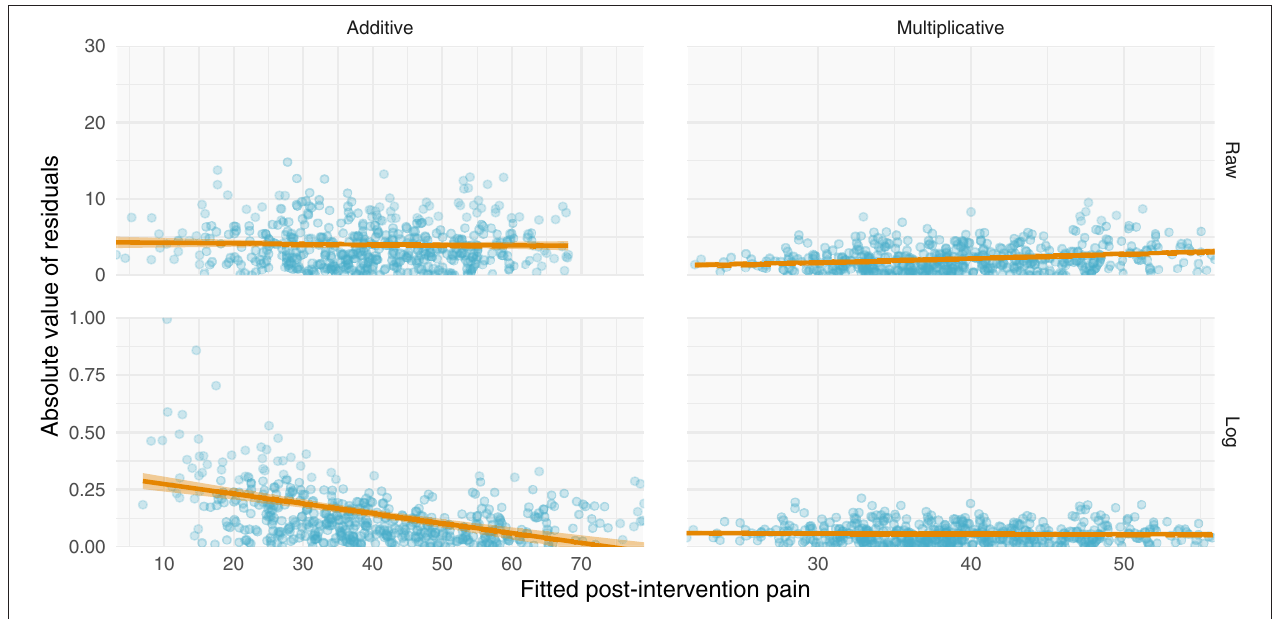
FIGURE 4 | Simulations of additive and multiplicative changes reveal differential residual behavior for raw and log-transformed ANCOVA models. (Left) data generated with have an additive structure have homoscedastic residuals when fit with a standard ANCOVA (top) but heteroscedastic residuals when fit with a log-transformed ANCOVA (bottom). (Right) data generated with a multiplicative structure have heteroscedastic residuals when fit on their raw scale (top) but homoscedastic residuals when log-transformed